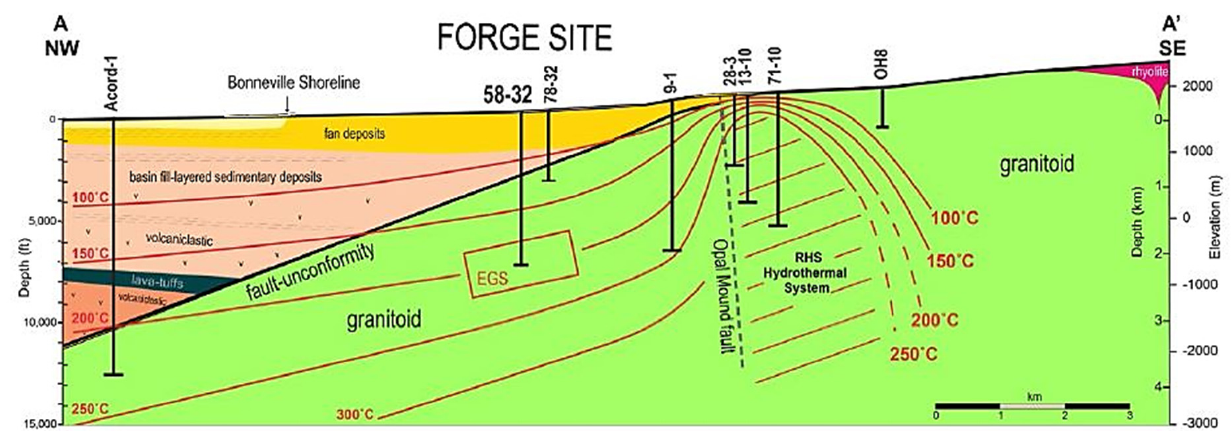
Figure 5. Cross section of the FORGE Utah site [25] based on the compilation from new field observations, well data, and previous work [26,27].